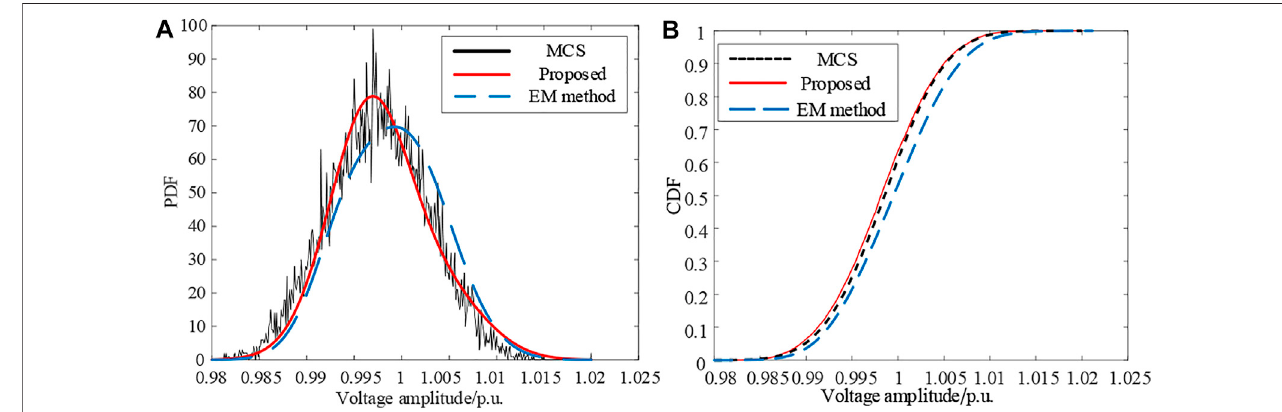
FIGURE 4 | The voltage amplitude probability distribution of bus M 1 . (A) The voltage amplitude probability density function of bus M 1 . (B) The cumulative distribution function of voltage amplitude at bus M 1 .